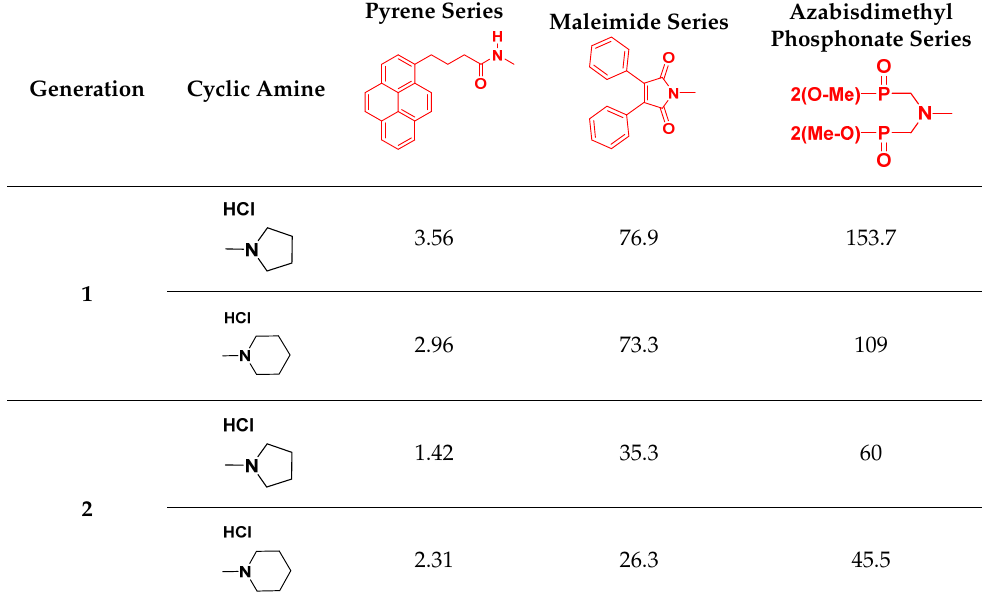
Table 2. CMC (µM) of amphiphilic phosphorus dendrons in water. Generation